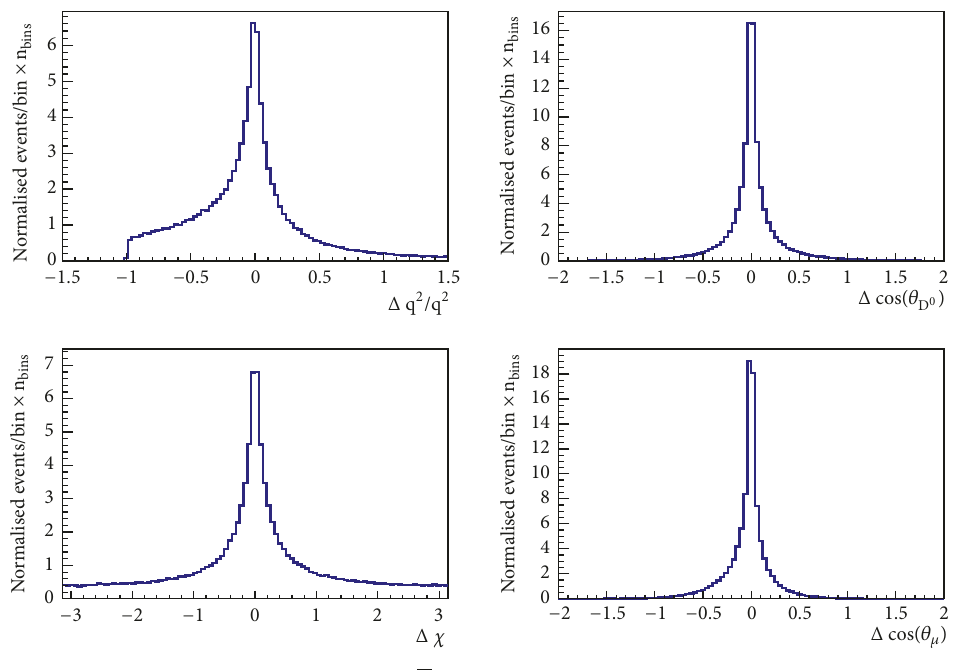
Figure 3: Resolution on the phase space variables for 𝐵 󳨀→ 𝐷 ∗+ 𝜇 − ] 𝜇 decays, obtained with full reconstruction algorithm.